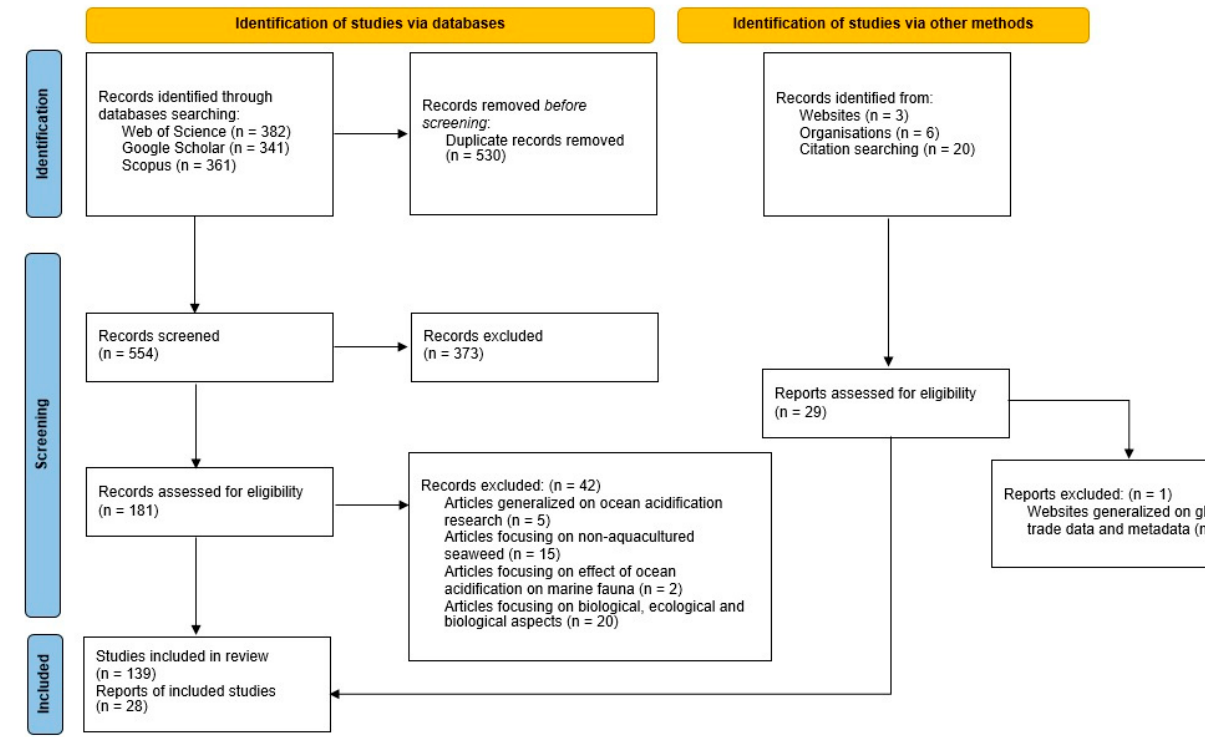
Figure 1. Flow diagram of the systematic review.